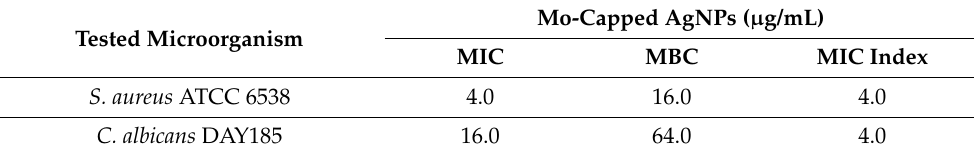
Table 5. MIC and MBC of Mo-capped AgNPs.